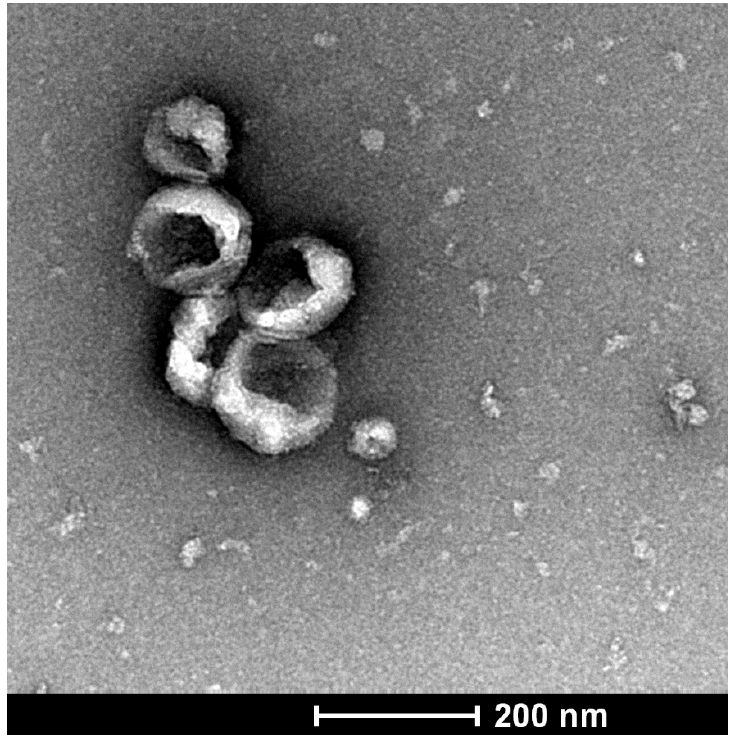
Figure 4. The figure depicts a cluster of exosomes isolated from pancreatic stellate cells from C57BL/6 mice. The exosomes are within their expected size range of 40–160 nm and confirm the typical cup-shaped morphology (original figure from the authors’ work).